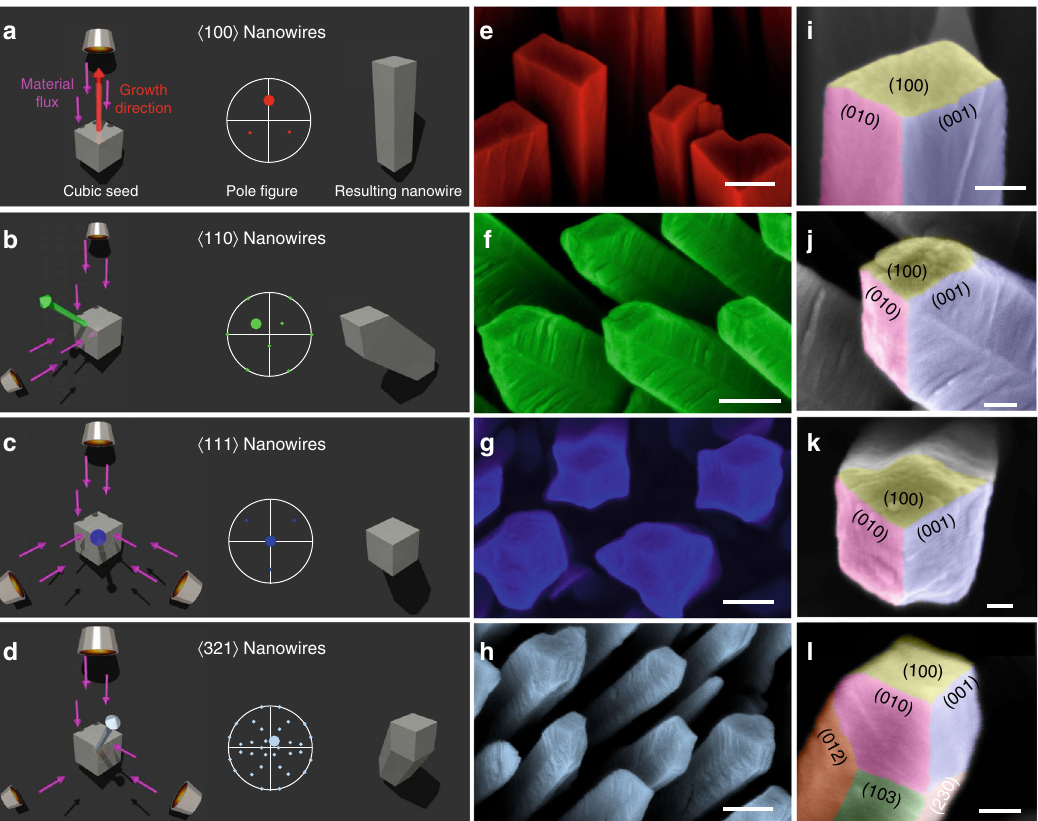
Fig. 3 Growth of FeCo nanowires along arbitrary 〈 hkl 〉 crystal orientations. a – d Schematic of material vapor fl ux pattern used to generate speci fi c crystal orientations. Sizes of crucibles represent different dwell times: small (0.5 s), medium (1.0 s), and large (1.5 s). Pole fi gures and resulting nanowire morphologies are also sketched. e – h Color-coded SEM micrographs of the corresponding experimental realizations. Scale bars are 200 nm. i – l High- resolution SEM micrographs of the nanowire end indicating the crystalline facets. Scale bars are 50 nm. All views are along the substrate